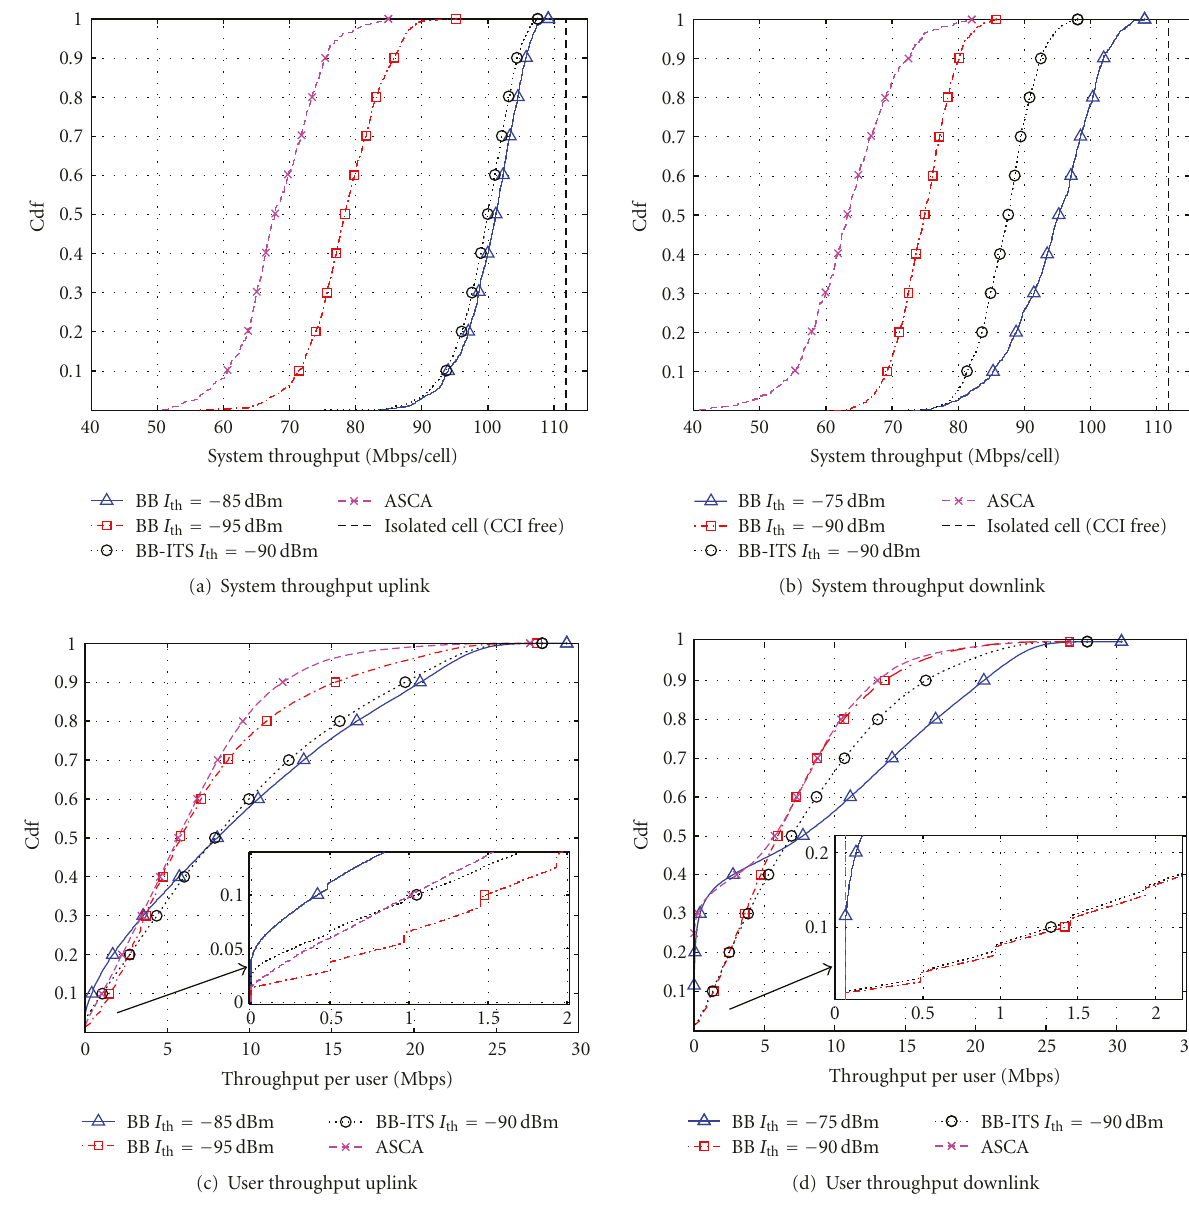
Figure 9: Cumulative distributive function (cdf) of system throughput and user throughput for BB-OFDMA with fixed BB power and BB- ITS. The performance for full-frequency reuse without interference protection termed ASCA is included for comparison. BB-ITS results in a favourable tradeo ff between fairness and system throughput both in uplink and downlink.